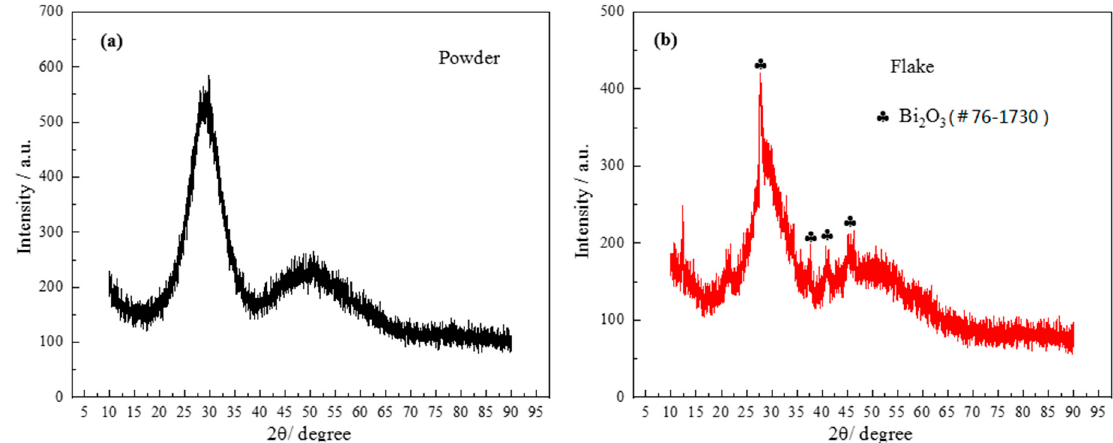
Figure 7. X-ray diffraction (XRD) patterns of powder and flake brazing filler glass: ( a ) powder; ( b ) flake.